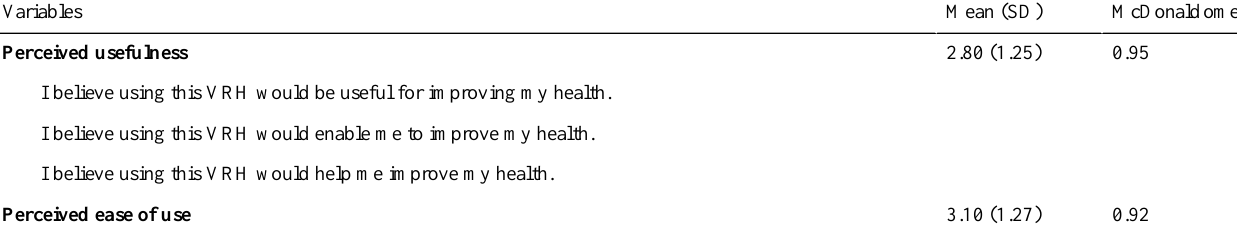
McDonald omegaMean (SD)Variables